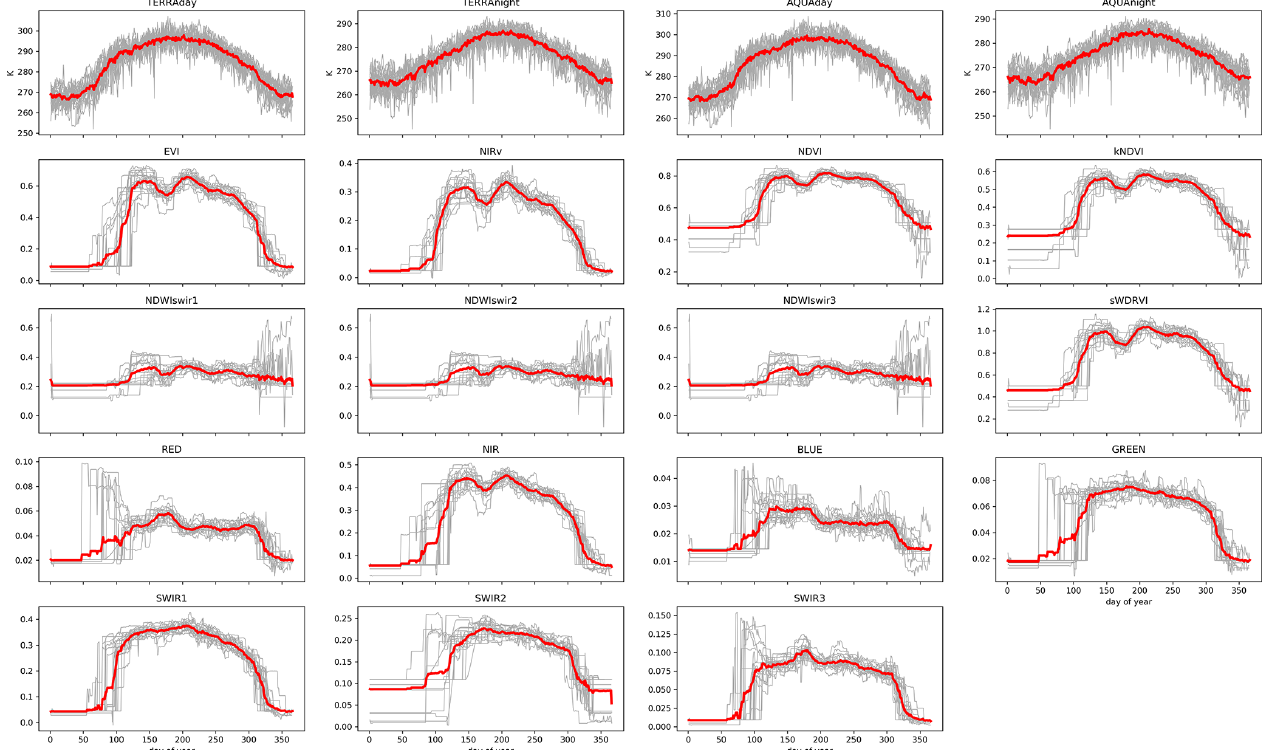
Figure 2. Median seasonal cycle (red) and individual yearly trajectories (grey) for MODIS LST (top row) and MODIS vegetation indices and surface reflectance (second to last rows) in the pixel containing the Austrian site Neustift (AT-Neu). Depending on the data set the central pixel measures 500m or